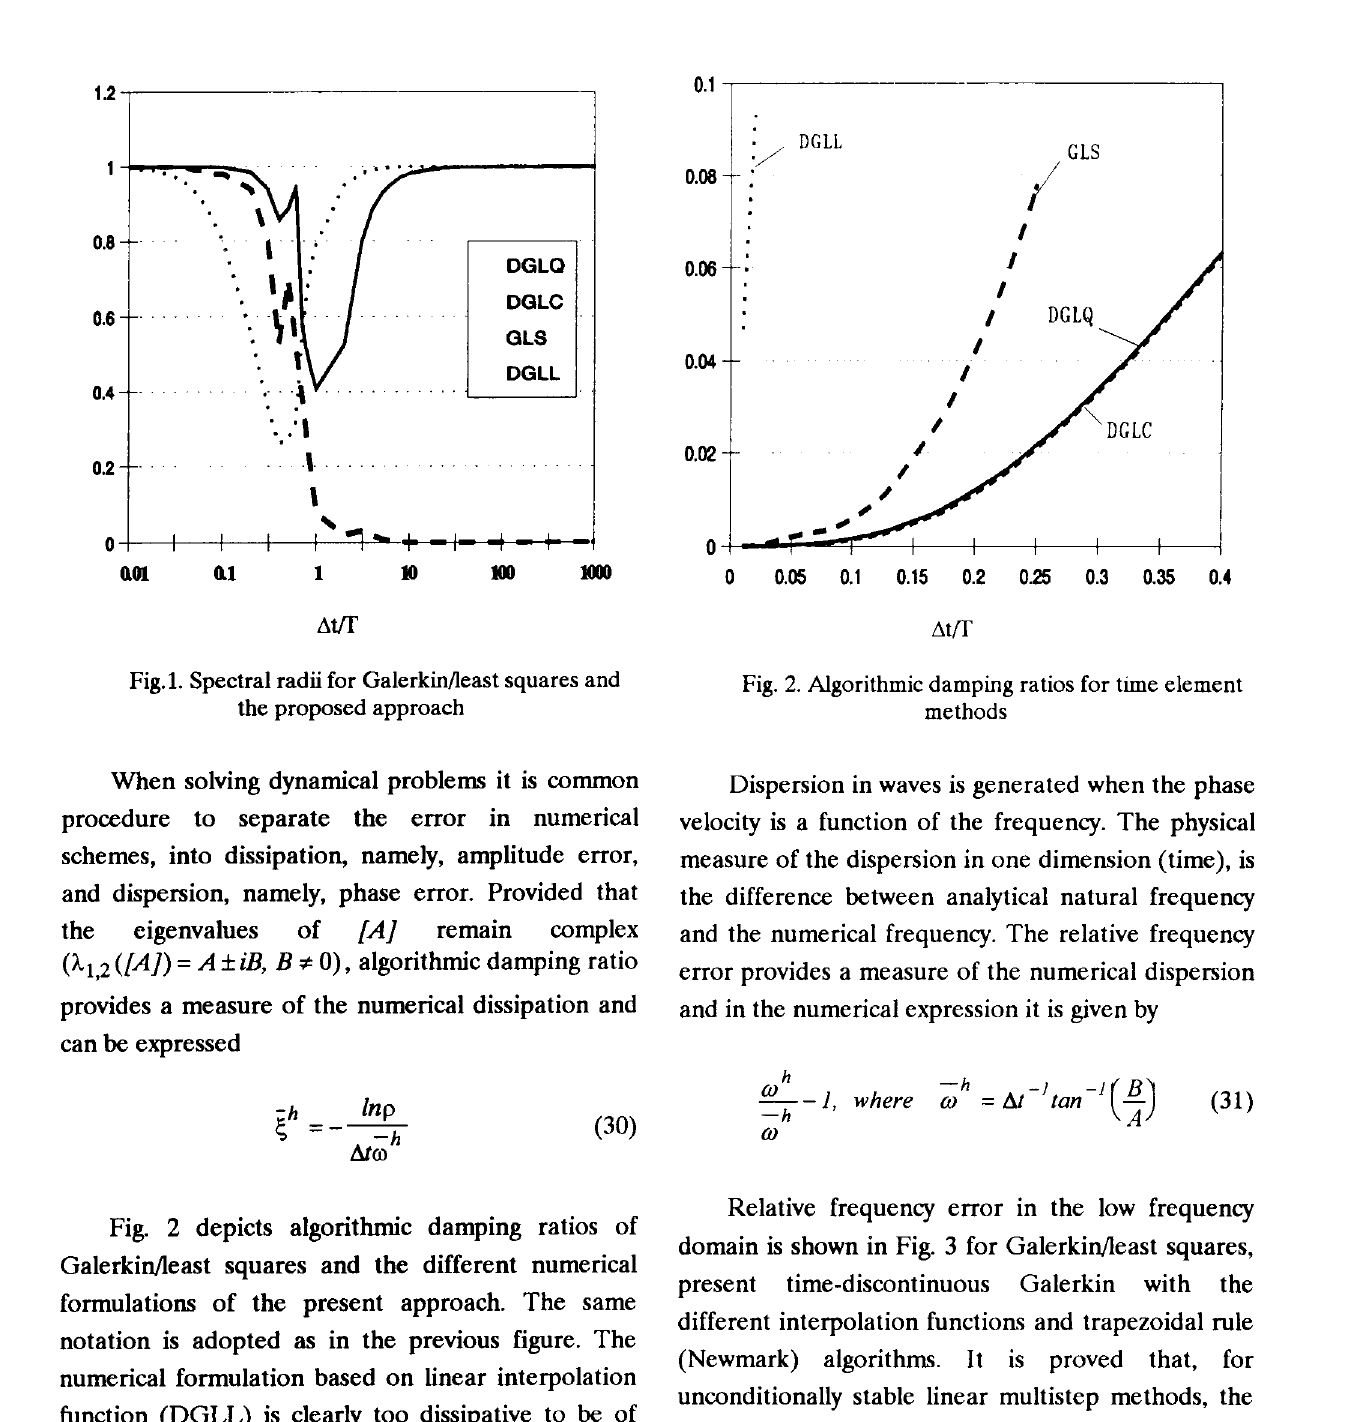
Fig.l. Spectral radii for Galerkin/least squares and the proposed approach